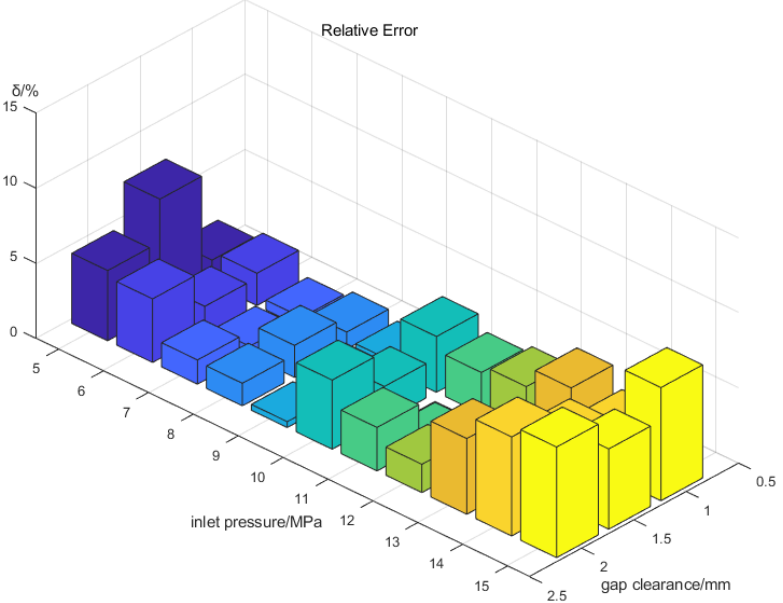
Figure 11. Relative error between simulations and experimental tests with different inlet pressure and gap clearance of suction cup- θ 20.